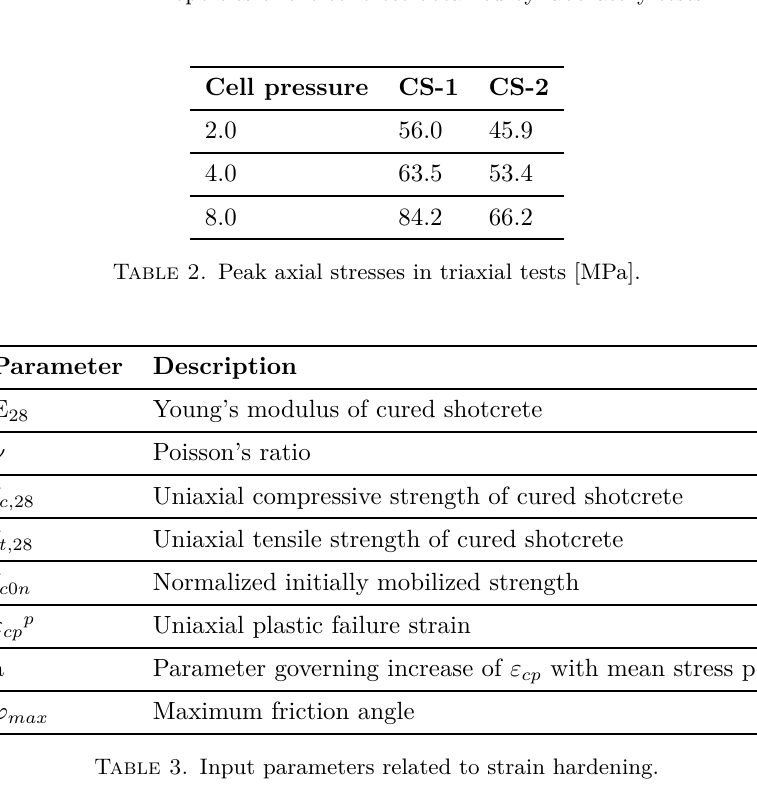
Table 1. Properties of the concrete obtained by laboratory tests.